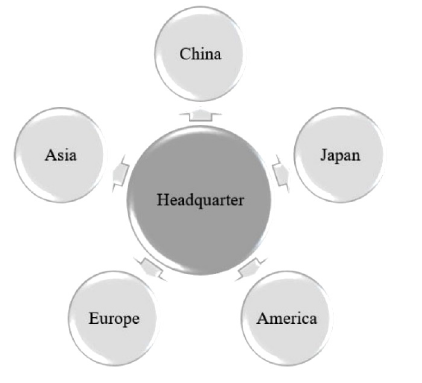
Figure 1. Organizational structure by geographic